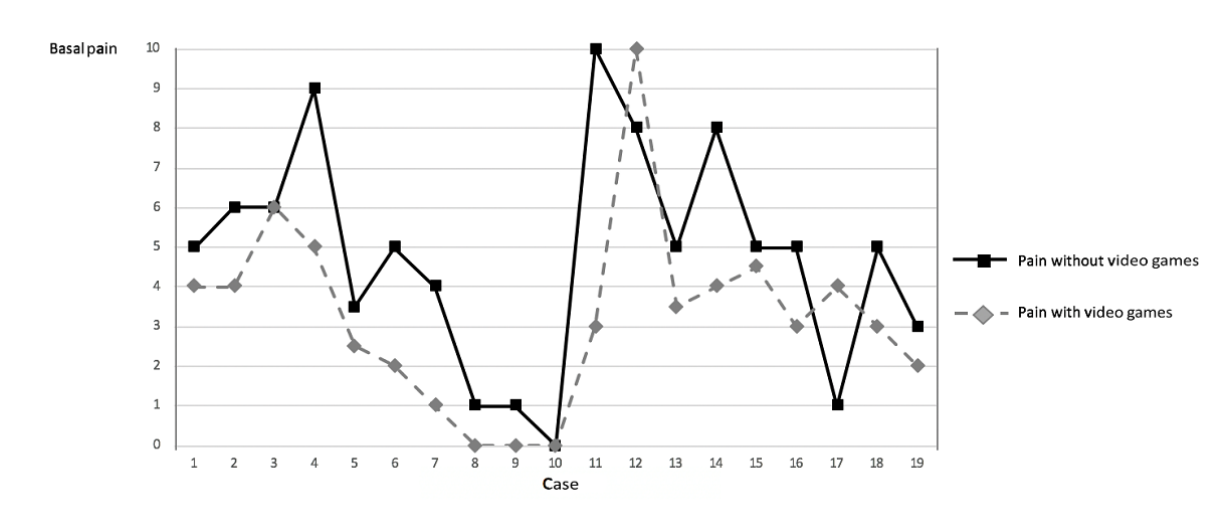
Figure 3. Variations in basal daily pain with and without the use of video games in each